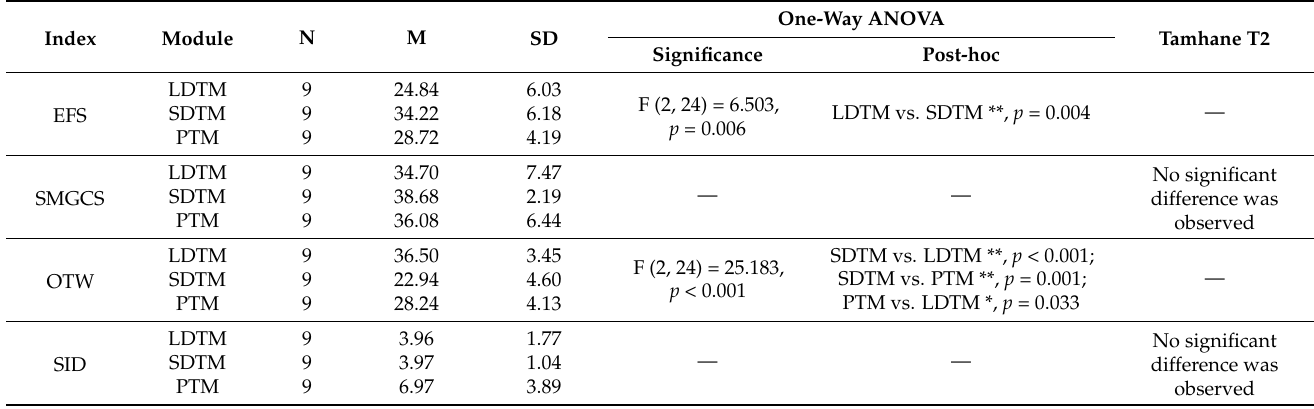
Table 3. The results and comparisons of fixation